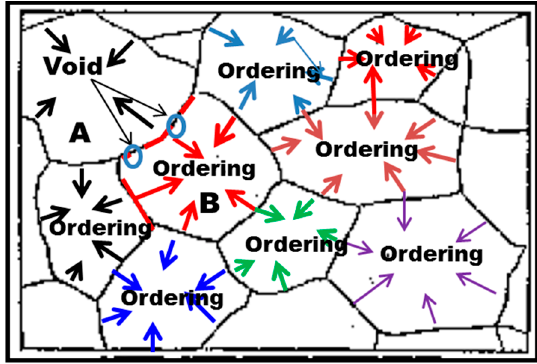
Figure 8. Diagram showing the spontaneous generation of localized tensile stresses in the vicinity of grain boundaries by ordering leading to lattice contraction. Note that voids are formed on the grain boundary between grains A and B when the localized tensile stress at a grain boundary between the two grains is lower than the grain boundary strength.